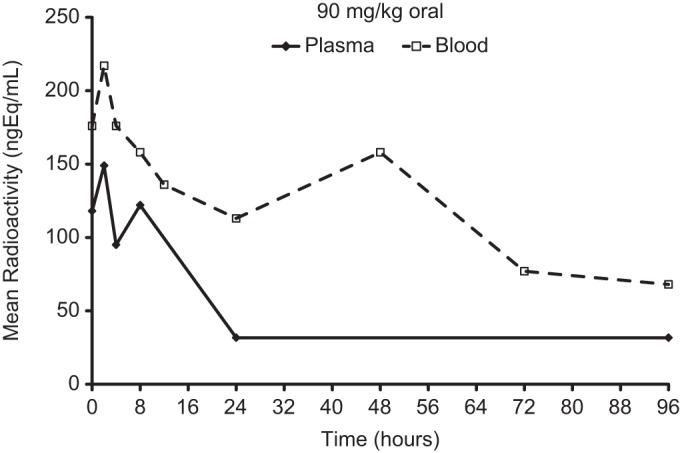
Mean concentrations of total radioactivity (quantified as nanogram equivalents per milliliter) in blood and plasma following a 90 mg/kg oral dose of 14C-omadacycline to Han/Wistar (HW) rats (n = 3).